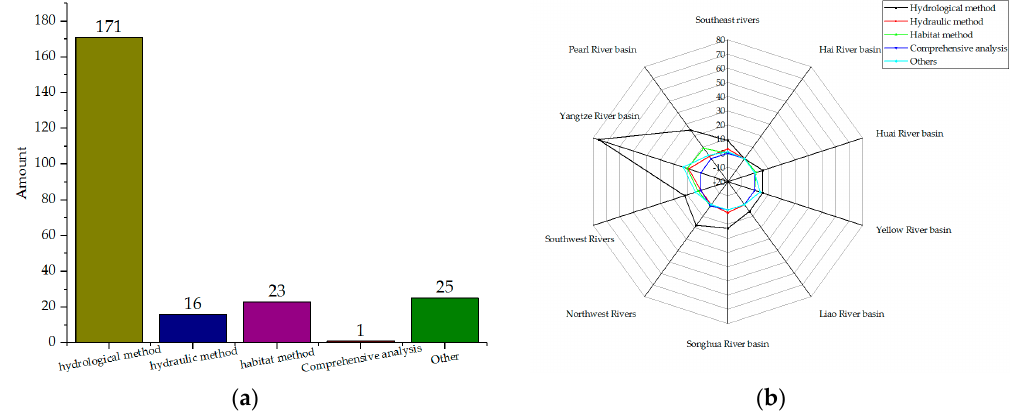
Figure 3. Current status of ecological flow (e-flow) methods applied in water storage and hydropower projects, China. ( a ) Frequency of use of e-flow methods for water storage and hydropower projects; ( b ) application of e-flow methods in different basins for water storage and hydropower projects.